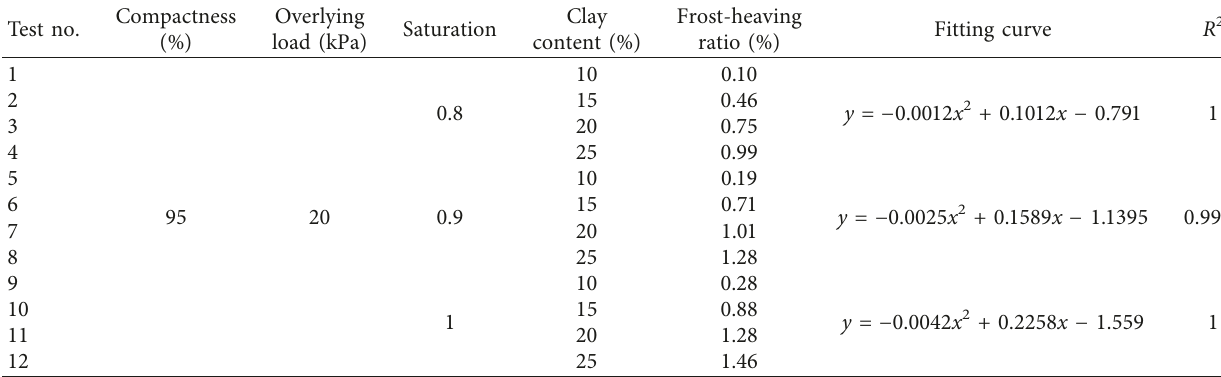
Table 3: Influence of various clay contents on frost-heaving ratio.